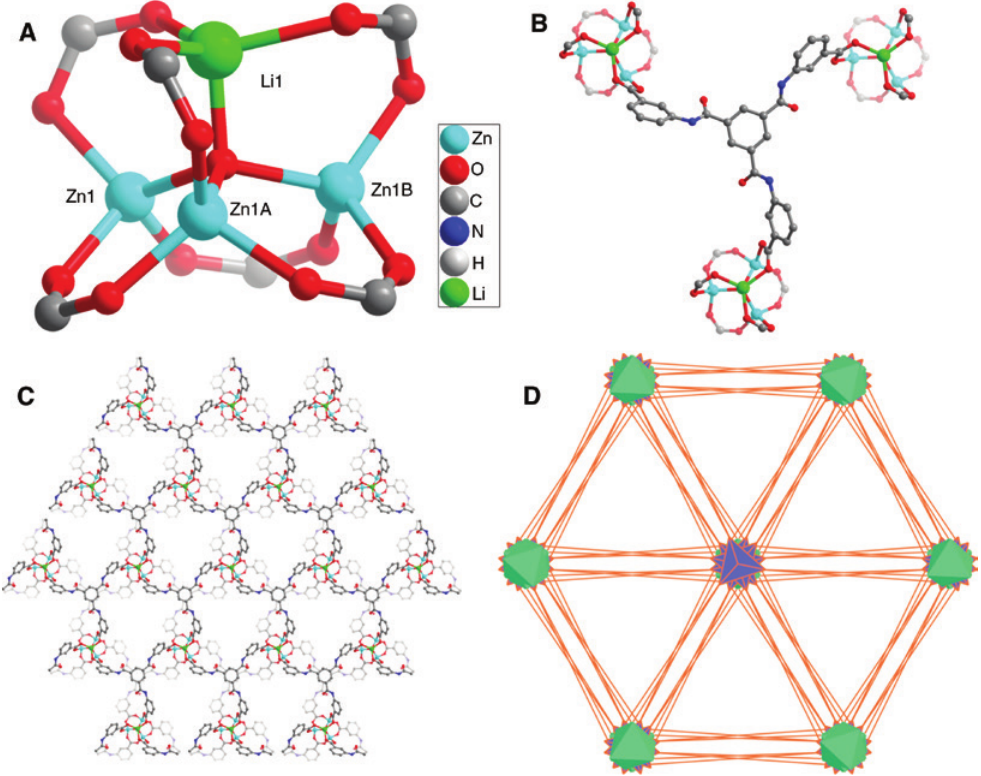
LiO} unit in 1 (symmetrical code: A y - x , - x , z ; B – y , x - y , z ). (B) The connecting mode for the BTA 3 − ligand. (C) The 2D bi-layered Figure 2: (A) The {Zn 3 network of 1 . (D) (3,6)-connected topology for 1 .